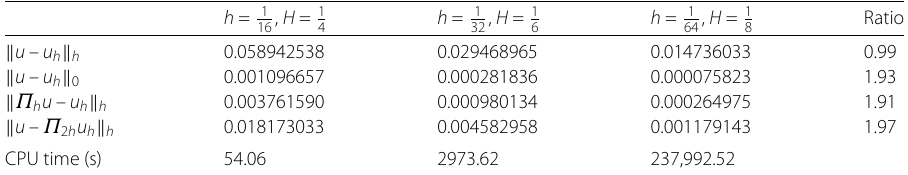
Table 1 Numerical results of two-grid Algorithm 4.1 at t = 1 ( τ = h 2 , h ≈ H 2 )